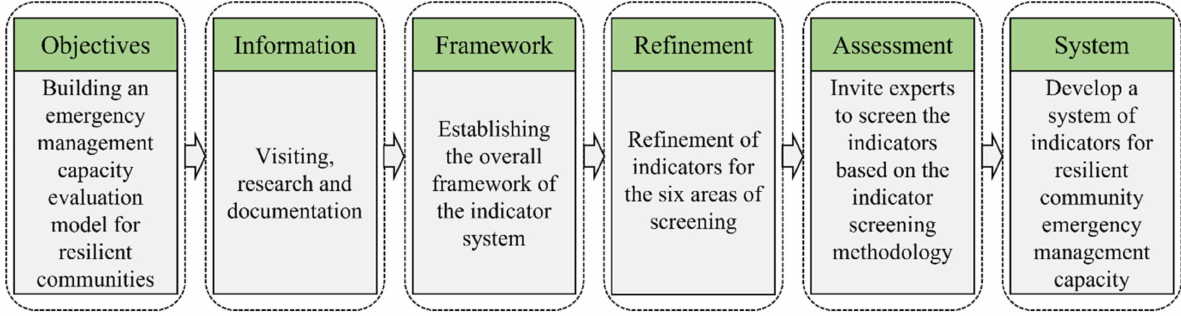
Figure 2. Flowchart for establishing an indicator